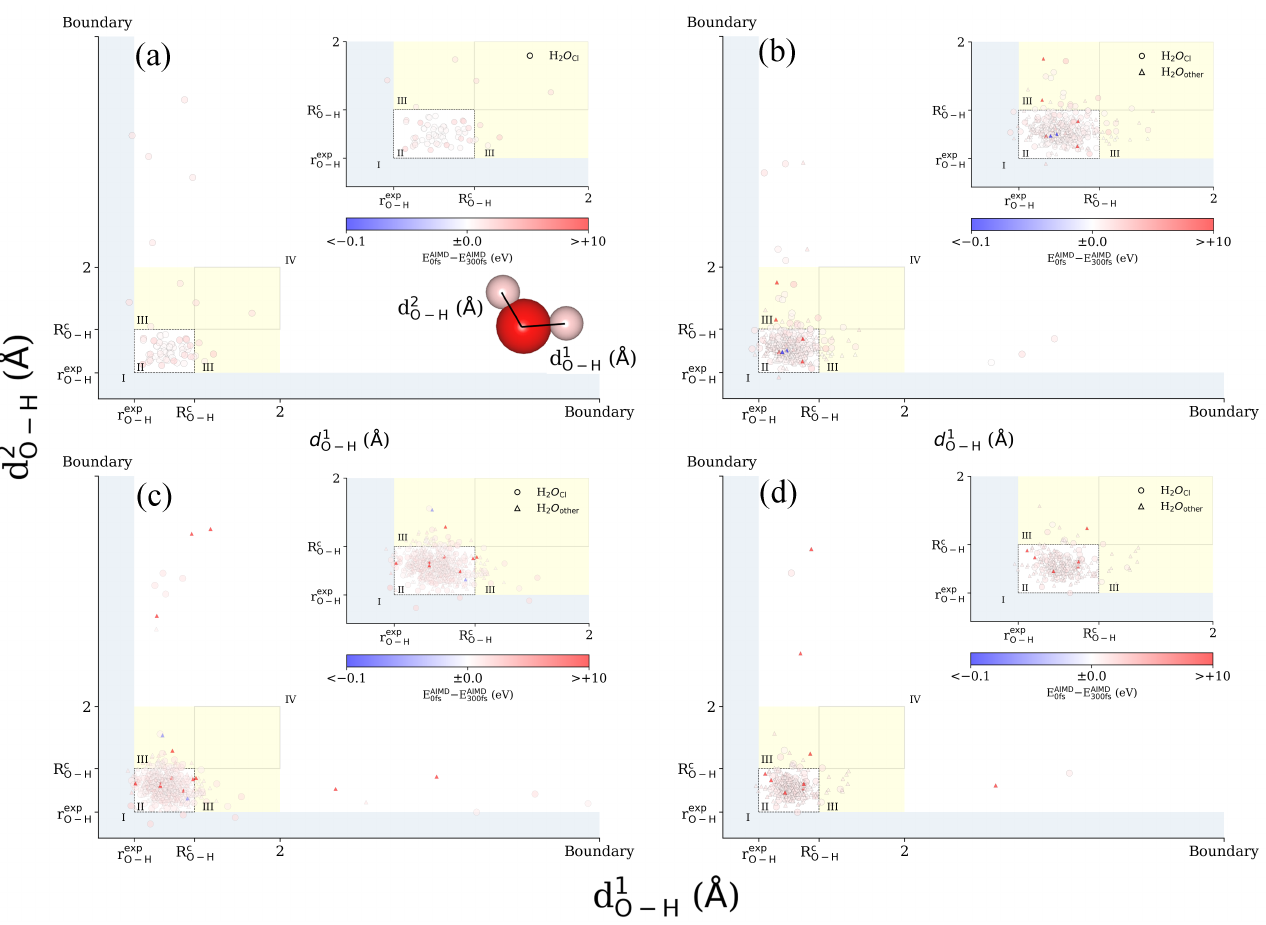
= 1.3 Å [16,37]; the r exp is O − H O − H